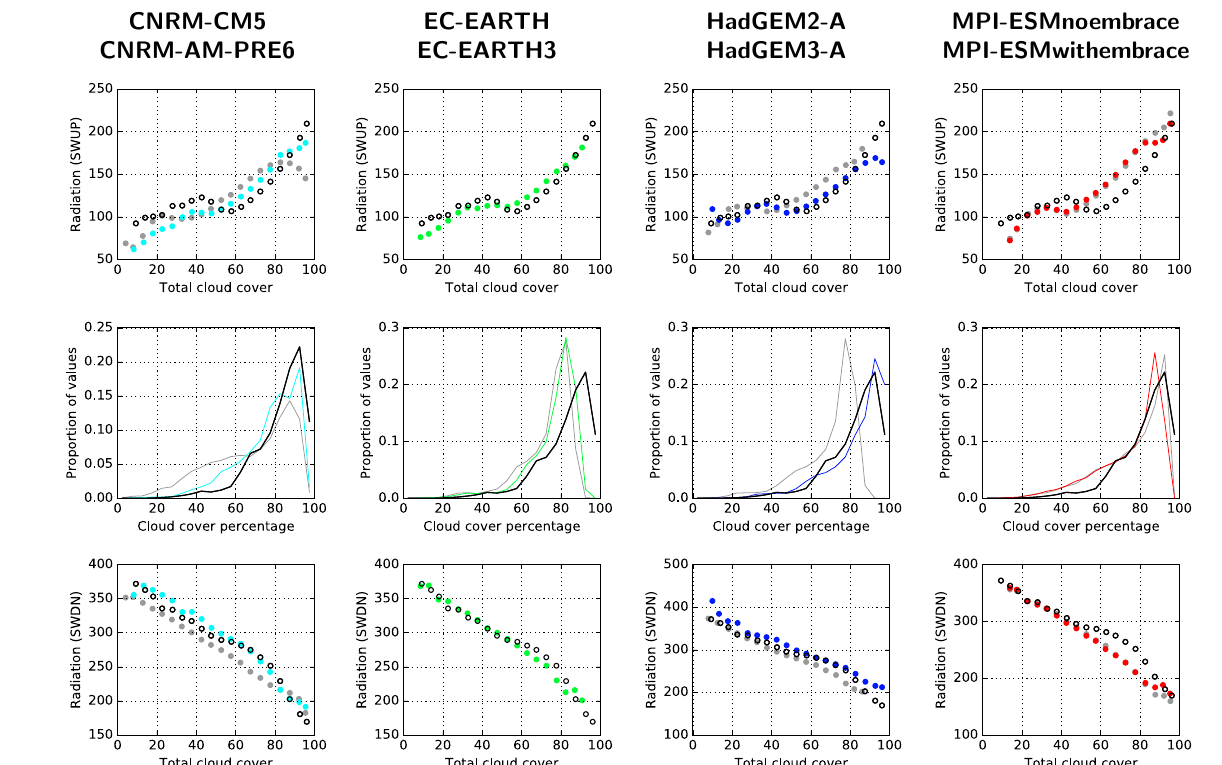
Figure 17. Top row panels: scatter plot of monthly mean TOA SWUP versus total cloud cover for the Southern Ocean region 30–65 ◦ S and season DJF averaged over the years 1986–2005 (MPI models 1980–1999, HadGEMs 1985–2004). Bottom row panels are the same for surface SWDN. Middle row shows fractional occurrence of monthly mean cloud cover over this region. Cloud observations are MODIS-L3 (2003–2014) and SWUP and SWDN are from CERES-EBAF (2001–2014). The EMBRACE-updated AMIP models are plotted in color, the corresponding CMIP5 models are shown in gray, and observations are in black. No radiation data from EC-Earth are